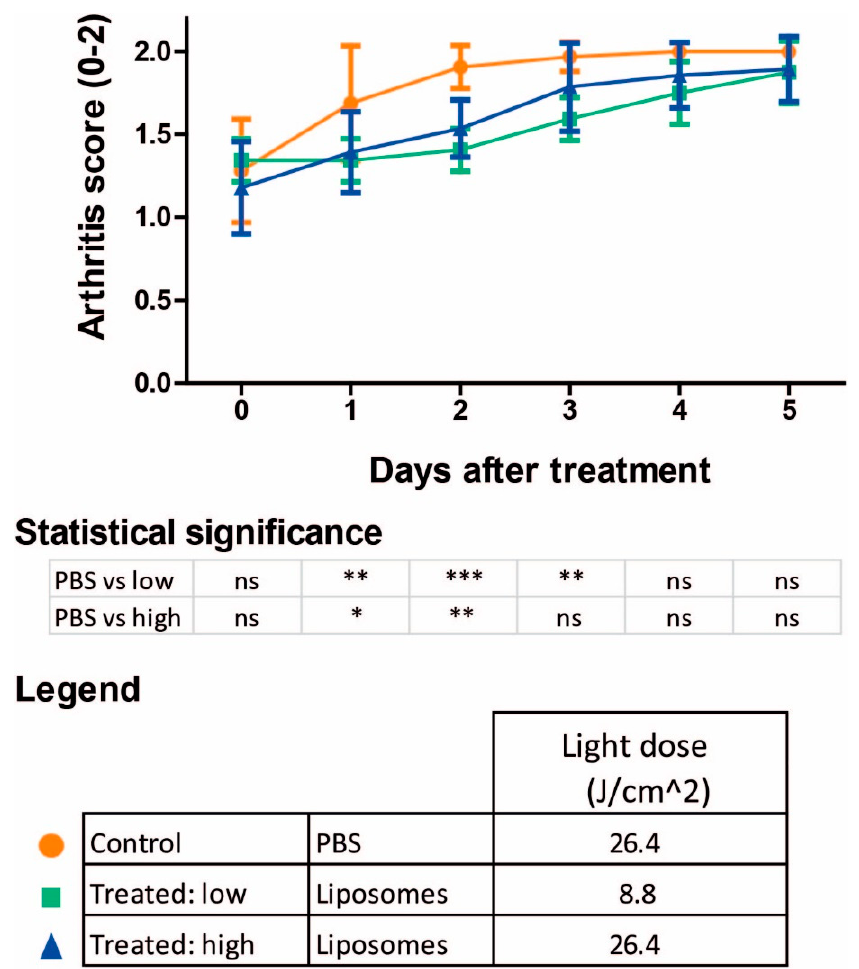
Figure 4. Development of arthritis over time after 700DX-liposome PDT. Initial arthritis development was slower after tPDT. Two-way ANOVA with Bonferroni post-test, * = p < 0.05, ** = p < 0.01, *** = p < 0.001 ( n = 8 mice/group).